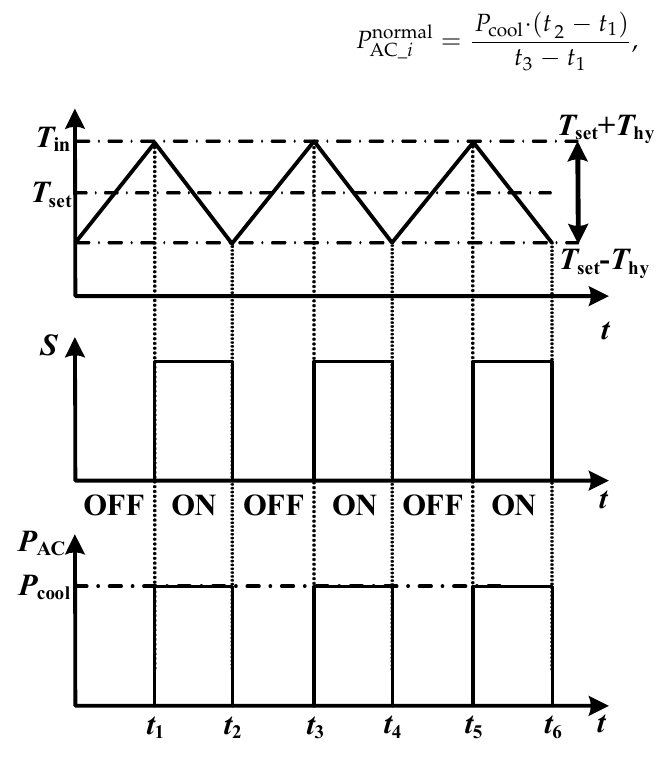
Figure 2. The operating characteristics of ACs.